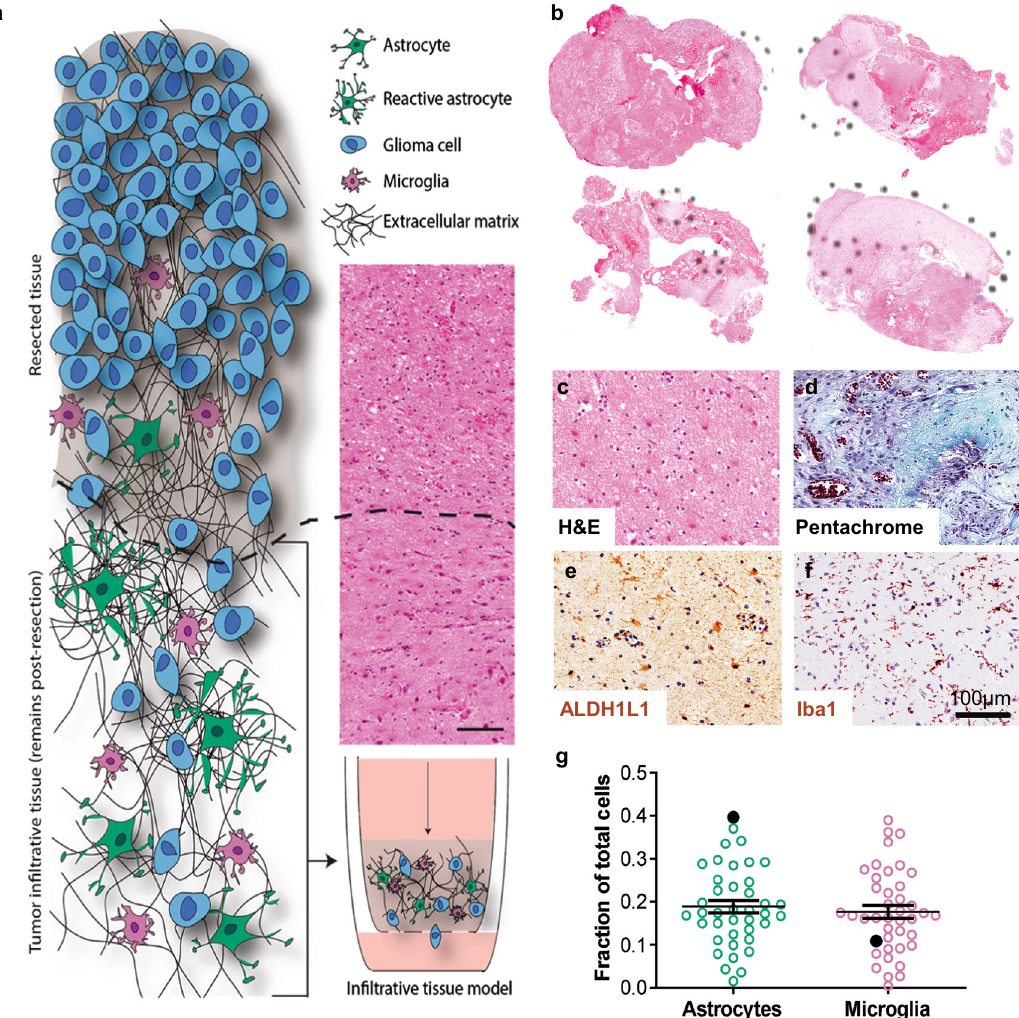
Fig. 1 Histological quanti fi cation of the invasive human glioblastoma microenvironment for in vitro model development. a Illustration of the invasive tumor border and the patient-driven approach to develop a relevant model. b Representative bright- fi eld scans of patient resection samples stained with hematoxylin and eosin (H&E), with dashed circles showing tumor-adjacent regions identi fi ed by a neuropathologist. c – f Representative bright- fi eld images of chromogenic stains on serial patient samples for H&E ( c ), movat pentachrome (matrix and mucin staining, d ), ALDH1L1 (astrocytes, e ), and Iba1 (microglia, f ). g Cell number quanti fi cation from our patient cohort samples ( N = 40) for astrocytes and microglia, represented as a fraction of total nuclei count. Solid black circles show data from a select